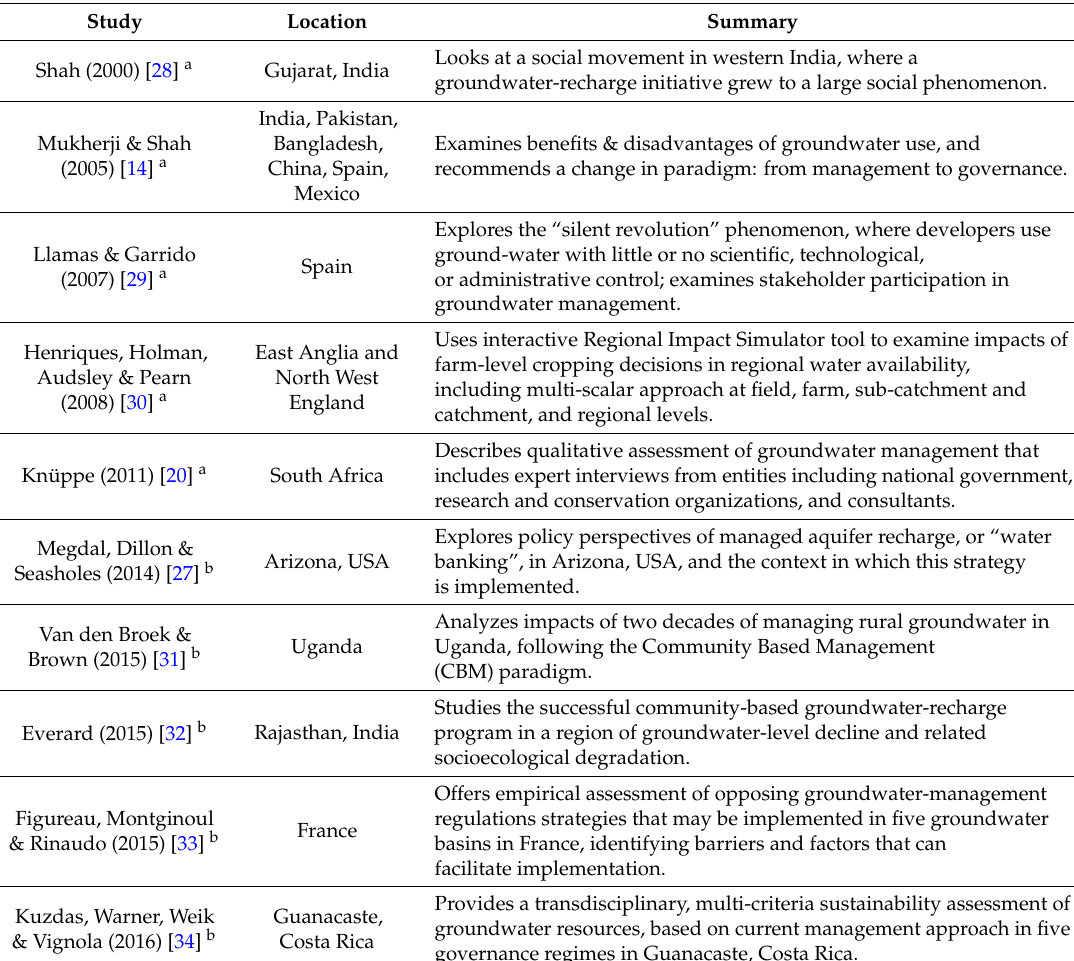
Table 1. Selected case studies. The 10 case studies reviewed, given in order of year of publication. Study